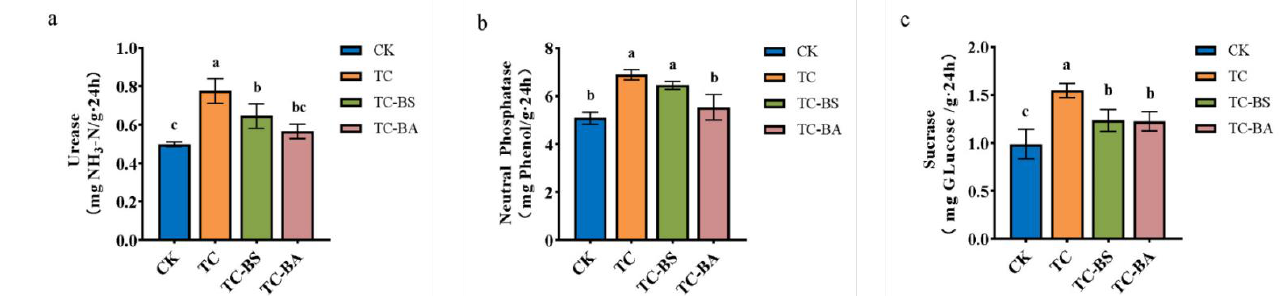
Figure 1. Effect of applying tomato plant residue compost and PGPR on the enzyme activity of ginger field soil. CK: no tomato plant residue compost or PGPR; TC: tomato plant residue compost; TC-BS: tomato plant residue compost + B. subtilis ; TC-BA: tomato plant residue compost + B. amyloliquefaciens SQR9. ( a ) Urease activity (mg NH 3 -N/g · 24 h); ( b ) neutral phosphatase activity (mg Phenol/g · 24 h); ( c ) sucrase activity (mg Glucose/g · 24 h), (different letters indicate significant difference, Duncan’s